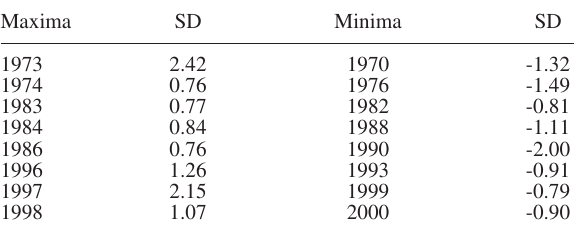
Table 1. – Extreme Brazilian sardine catches and respective stand- ard deviations.